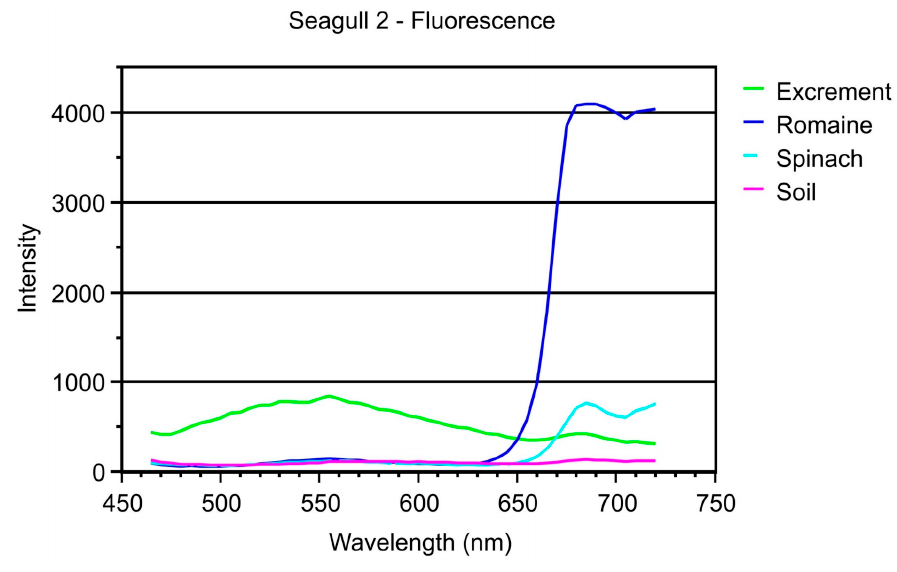
Figure 4. Fluorescence spectra for a gull dropping, romaine leaf, spinach leaf, and soil.